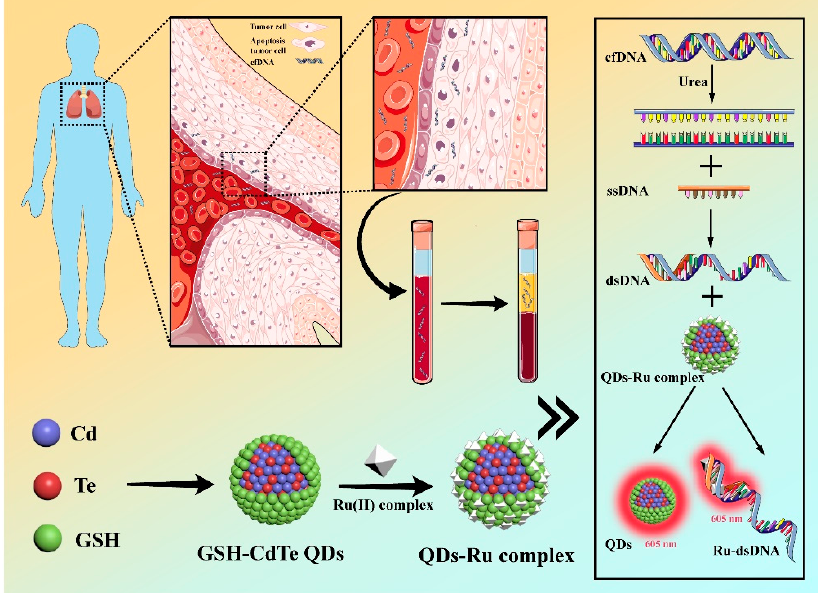
Figure 1. A schematic illustration of the QDs-Ru complexes consisted of water-dispersible GSH-CdTe QDs and fluorescence-quencher Ru(II) complexes as robust fluorescent “turn-on” clutch probes for the detection of cancer-specific cfDNA in patient plasma samples.